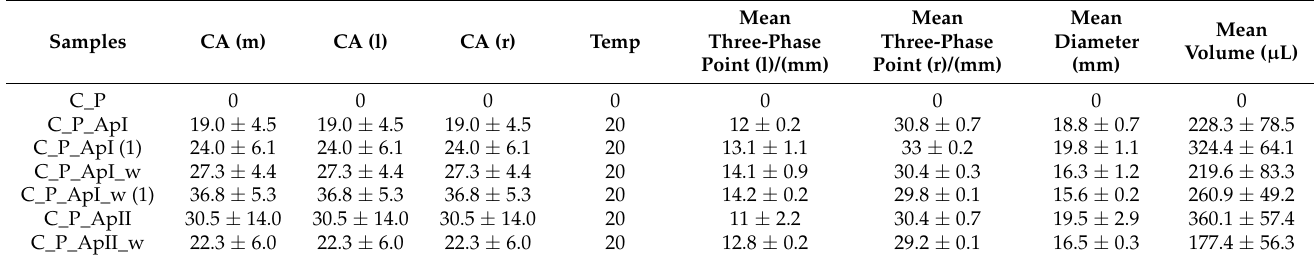
Table 3. Results of the contact angle with standard deviations of the contact angle for the samples in plain weave.